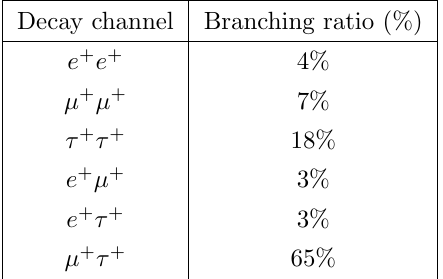
Table 6 . The branching fractions of H ++ for the most conservative scenario. The mass hierarchy used to produce the branching ratio is the normal hierarchy with sin 2 (cid:18) 23 = 0 : 428, m 1 = 0 : 0106 eV, (cid:11) 1 = 23 : 4 (cid:14) and (cid:11) 2 = 194 : 7 (cid:14) . For other PMNS parameters, we use parameters shown in the table